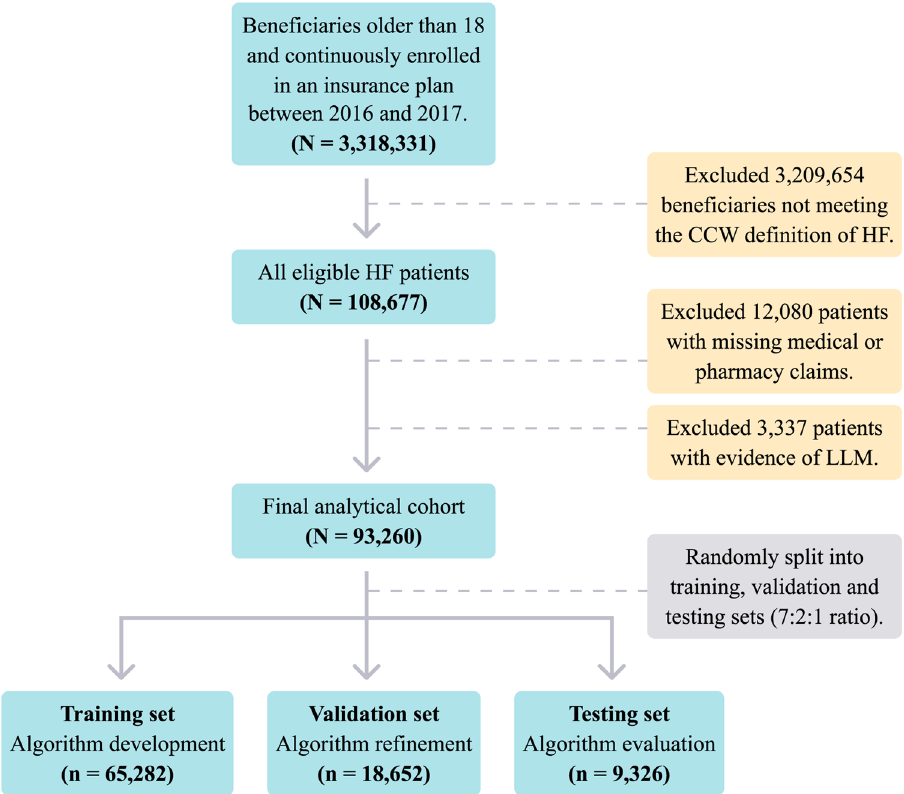
Figure 1. Patient Selection Process and the Creation of Training, Validation, and Testing Datasets. Patients were first defined as HF patients using the CMS’ CCW algorithm. Next, patients with missing data or existing LLM were excluded. Finally, the cohort was randomly split using a 7:2:1 ratio into training, validation, and testing datasets. The figure was created using Adobe Illustrator Creative Cloud version 24.2.1 21 . CCW, Chronic Condition Warehouse; HF, Heart Failure; LLM, Life-Limiting